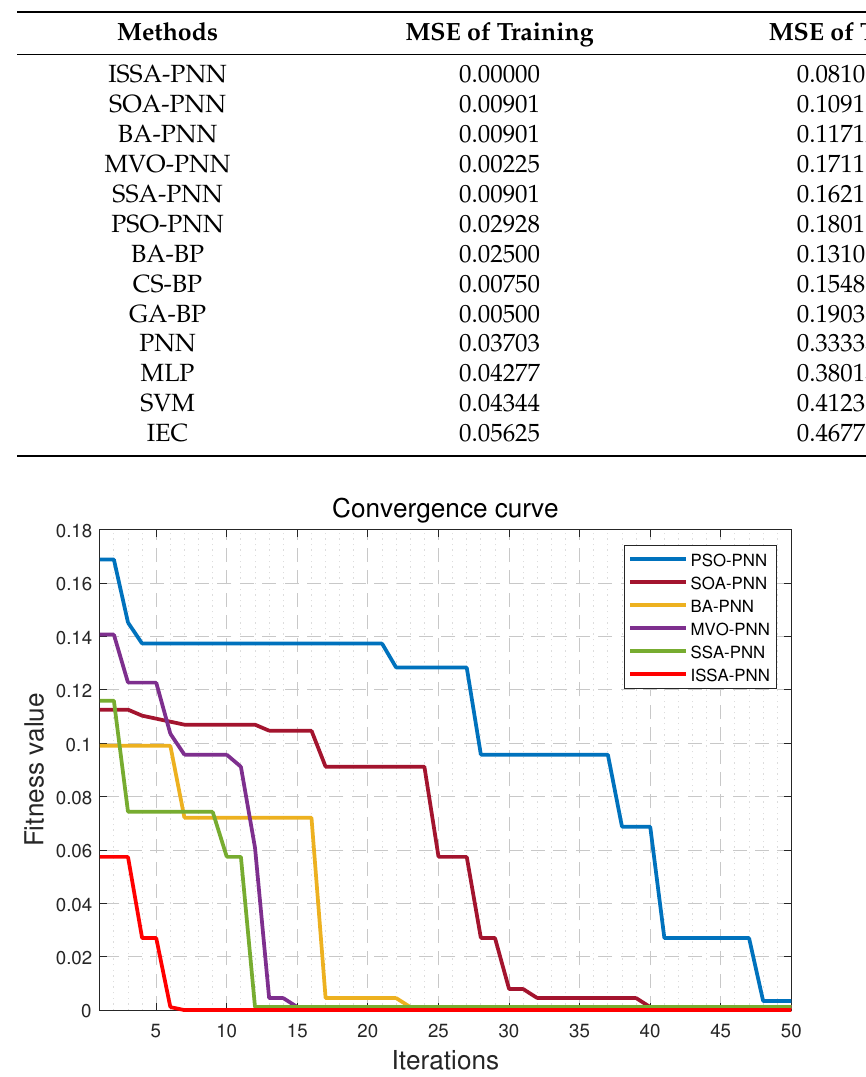
Figure 7. The fitness value curve of different optimization